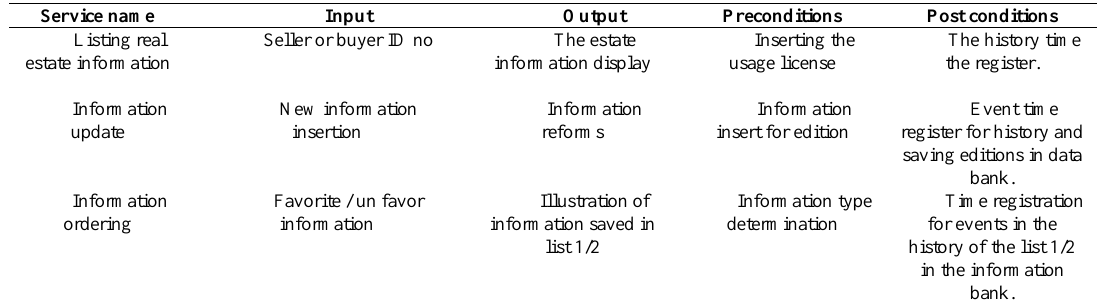
Table13. Service model of house buying & selling